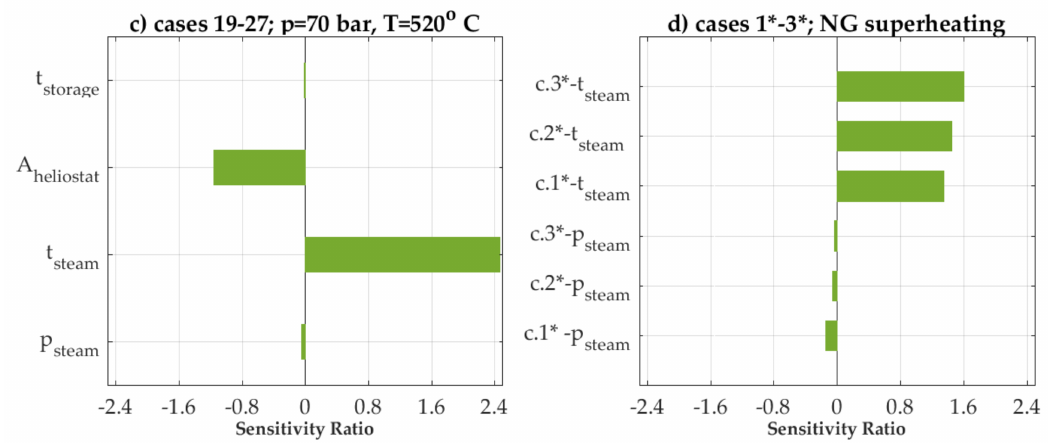
Figure 9. Sensitivity Ratio of thermoecological cost for the analyzed cases ( a – d ).